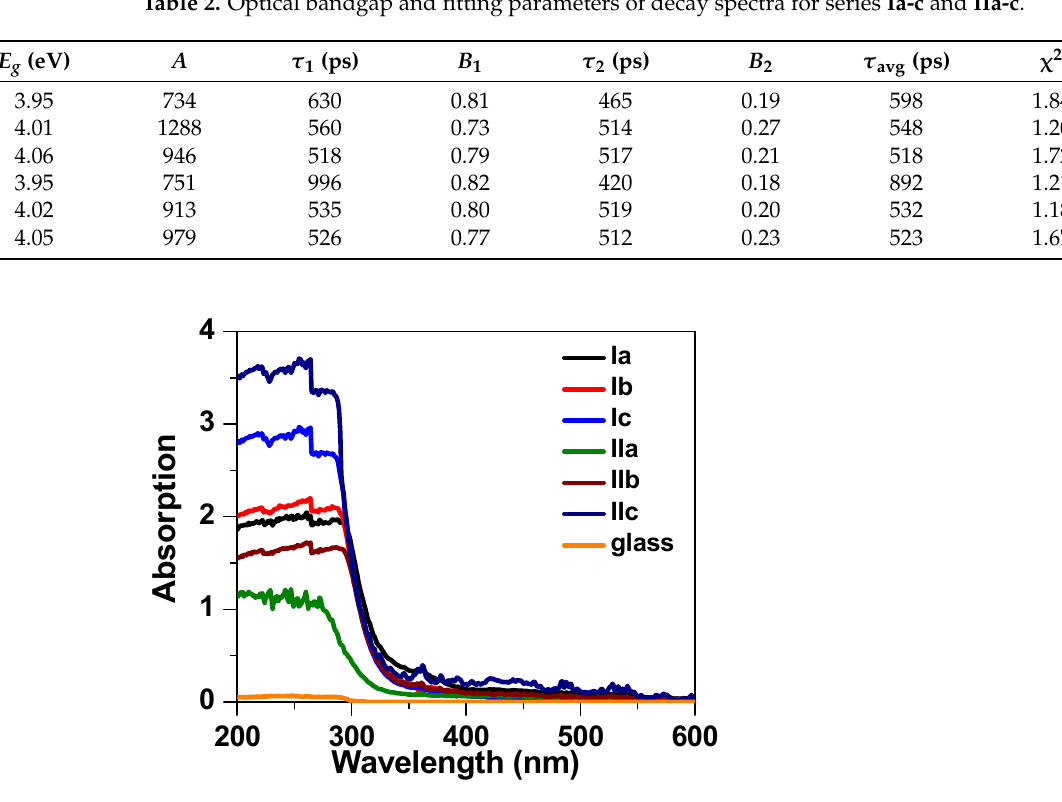
Figure 6. Absorption spectra of the liquid crystalline solid films on glass slides.